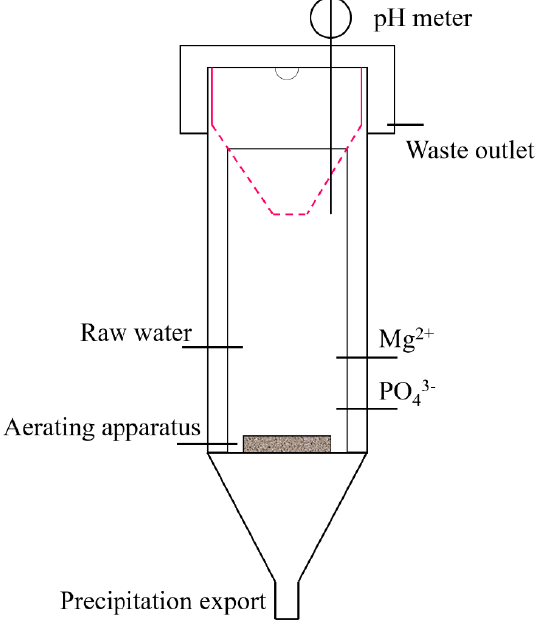
Figure 1. Schematic diagram of the magnesium ammonium phosphate (MAP) reaction equipment.